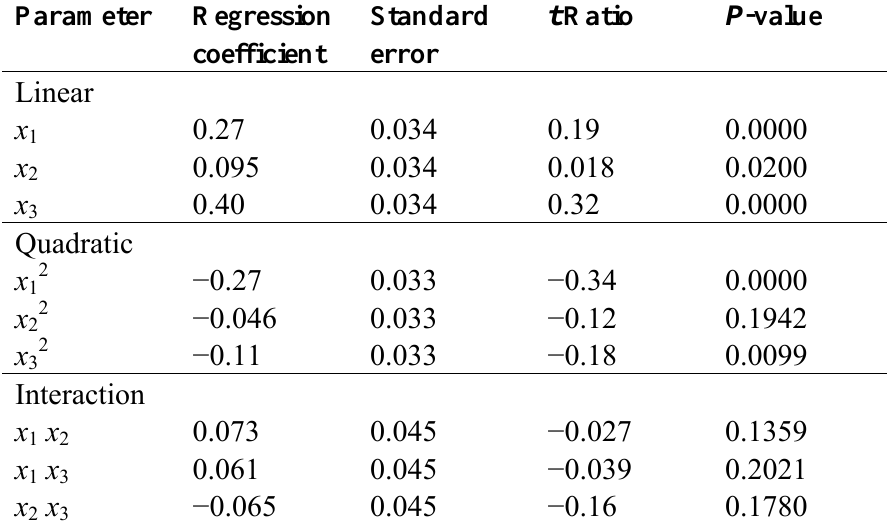
Table 2. Regression coefficients of the predicted quadratic